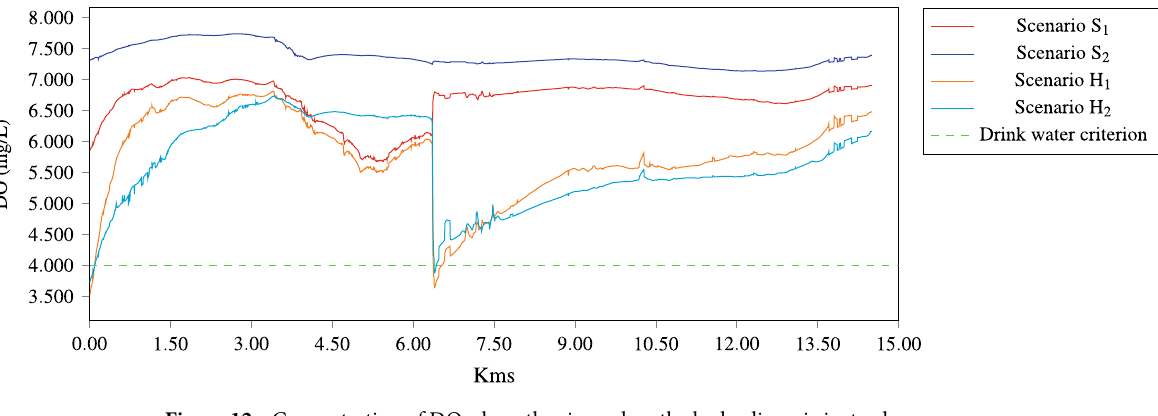
Figure 12. Concentration of DO, along the river when the hydrodinamic is